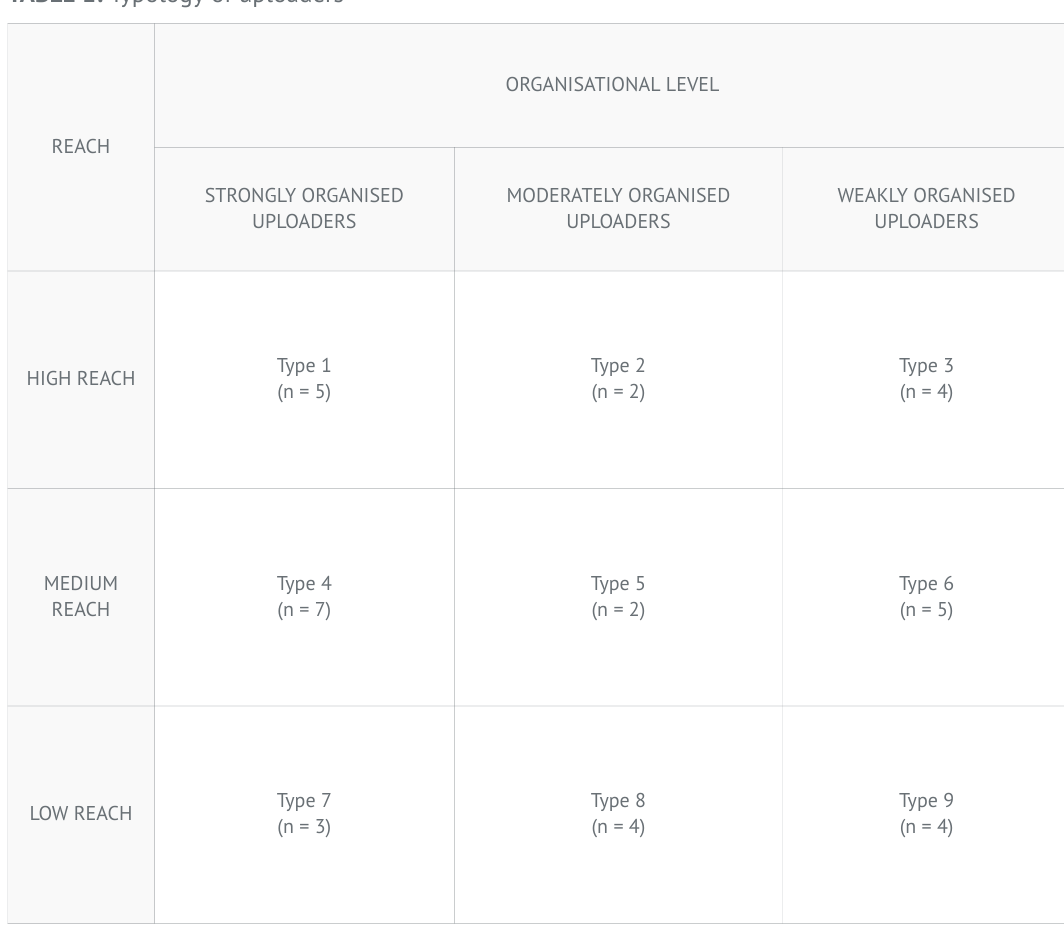
TABLE 1: Typology of